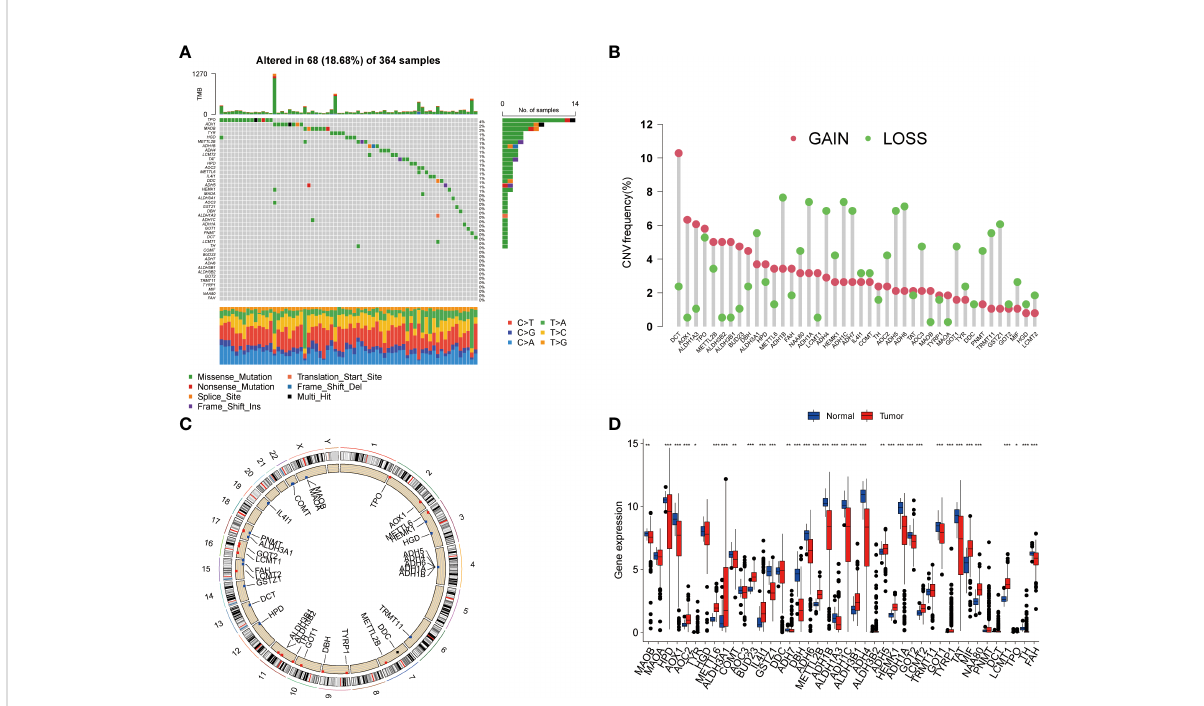
FIGURE 1 Genetic variations and transcriptional expression of TRGs in HCC. (A) The distribution and mutation frequencies of 42 TRGs in the TCGA HCC cohort. (B) Frequencies of CNV alterations of TRGs in HCC. The height of the column represents the alteration frequency. (C) Locations of CNV alterations in TRGs on chromosomes. (D) Expression distributions of 44 TRGs between HCC tumor and normal tissues. *p < 0.05, **p < 0.01, ***p < 0.001. TRGs, tyrosine metabolism-related genes; HCC, hepatocellular carcinoma; TCGA, The Cancer Genome Atlas; CNV, copy number